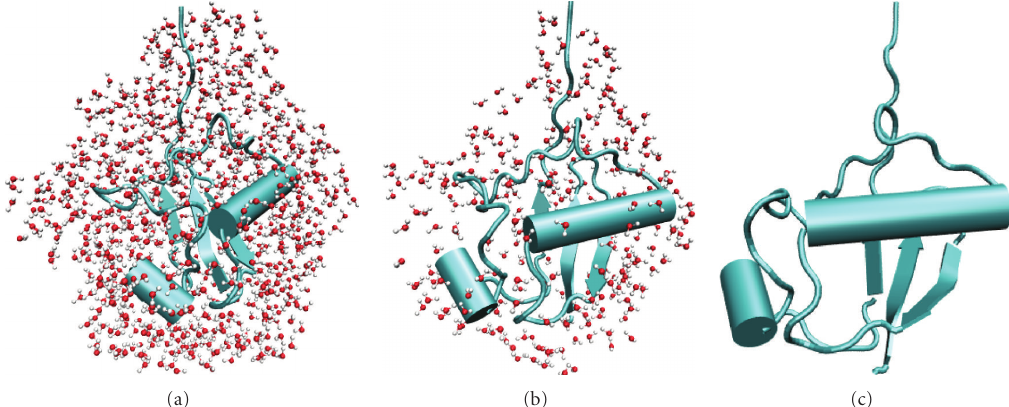
Figure 1: Perspective view of equilibrated ubiquitin-water complexes for evaporation simulation at 300 K. (a) Thick hydration shell. (b) Thin hydration shell. (c) Vacuum structure.